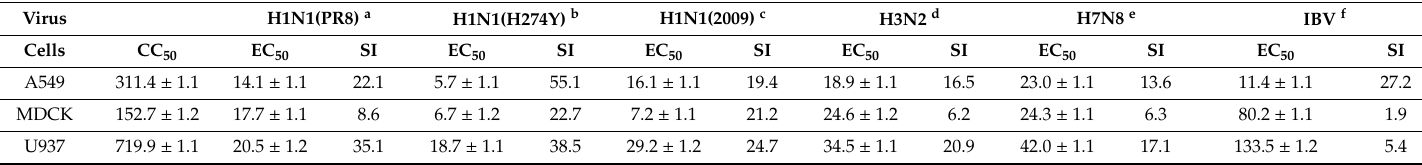
Table 1. Inhibition of 6 di ff erent influenza virus strains in A549, Madin–Darby Canine Kidney (MDCK), and U937 cells by Caesalpinia decapetala (Roth) Alston (EEC). Virus H1N1(PR8)